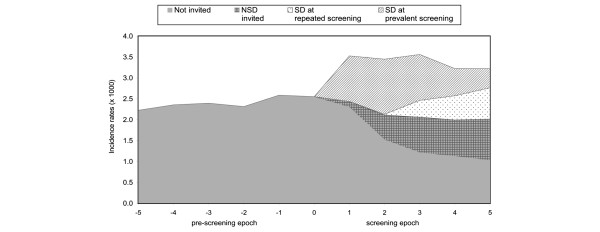
Breast cancer incidence rates by method of detection, on the screening time scale. The participants were aged 50 to 74 years. SD, screen detected; NSD, not screen detected.